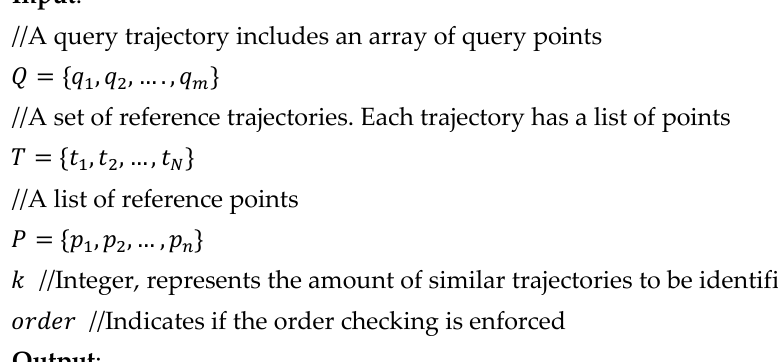
Algorithm 1 Parallel k ‐ BCT: identify a top K similar trajectories in